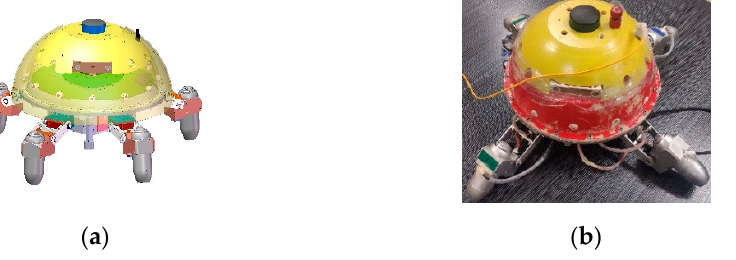
Figure 1. The model structure of the amphibious spherical robot (ASR). ( a ) The overall appearance of the ASR-V robot; ( b ) The physical object of the ASR-V